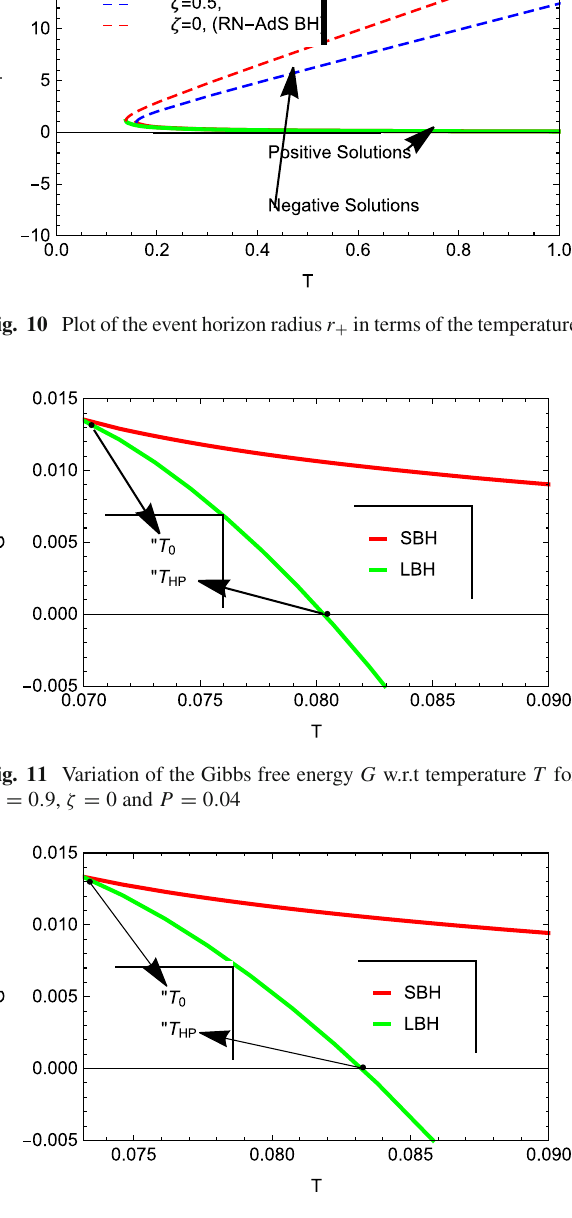
Fig. 12 Variation of the Gibbs free energy G w.r.t temperature T for (cid:20) = 0 . 9, ζ = 0 . 1 and P = 0 . 04